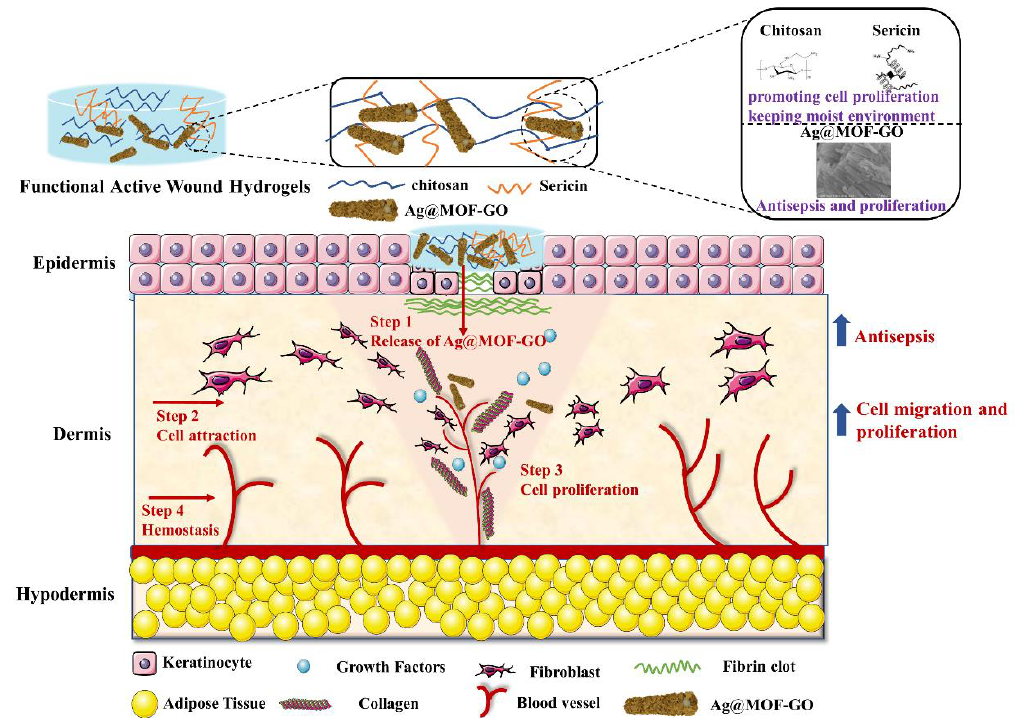
Figure 1. The design of chitosan/silk sericin (CS/SS) hydrogels incorporated with silver nanoparticles@organic frame- works/graphene oxide (Ag@MOF–GO).